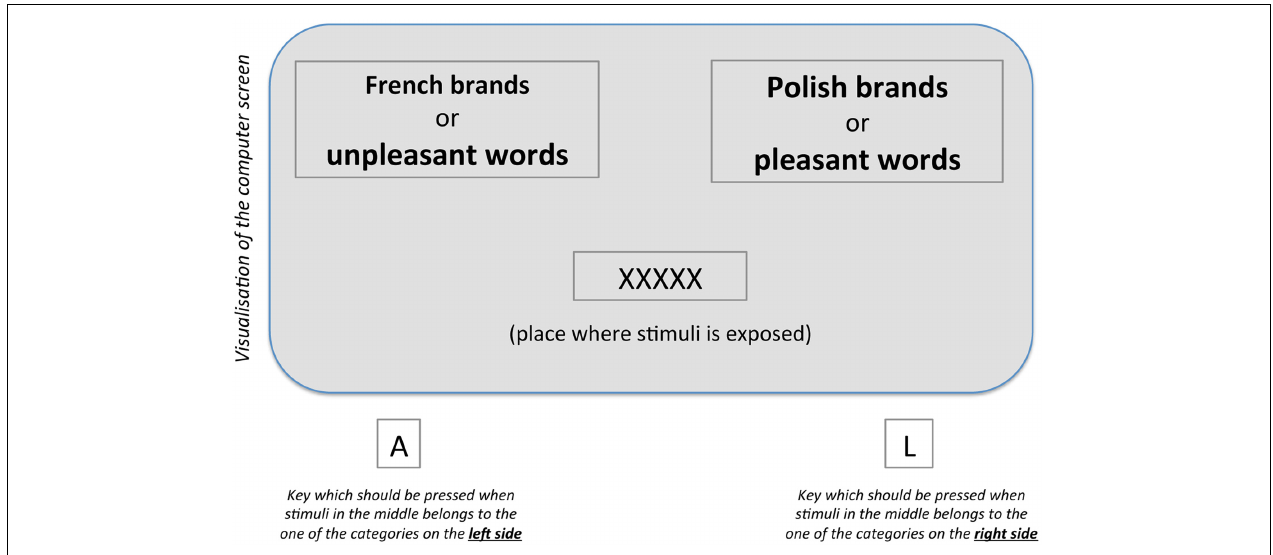
FIGURE 1 | Example of the Implicit Association Test (IAT) to measure implicit attitudes toward Polish and French brands.